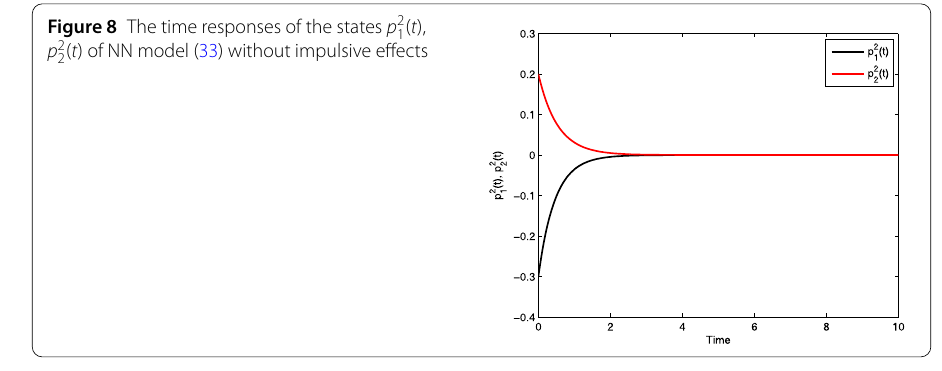
Figure 9 The time responses of the states p 12 1 ( t ), p 12 2 ( t ) of NN model (33) without impulsive